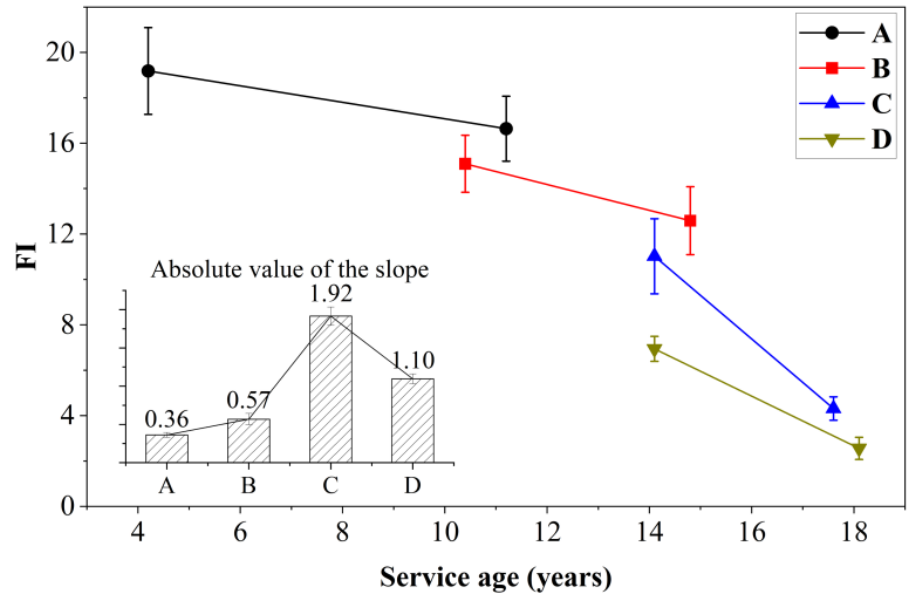
Figure 9. FI versus service age for samples of top layer with similar ESALs. Figure 10 presents the relationship between tensile strength and ESALs. Compared with FI, the tensile strength declined with increasing ESALs at a much slower rate. From the smallest to the largest ESAL interval, the FI decreased by 79.57%; however, the tensile strength decreased by only 30.19%. Therefore, for the top layer samples, the FI was more sensitive to the ESALs than the tensile strength.